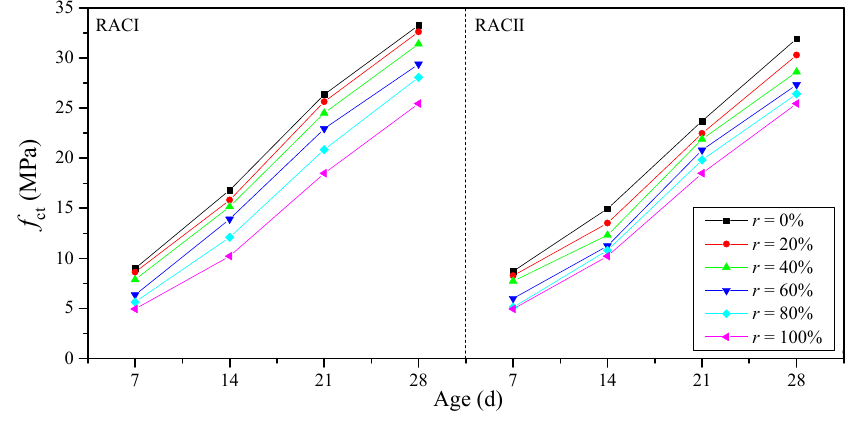
Figure 3. Compressive strength of RACs with age.